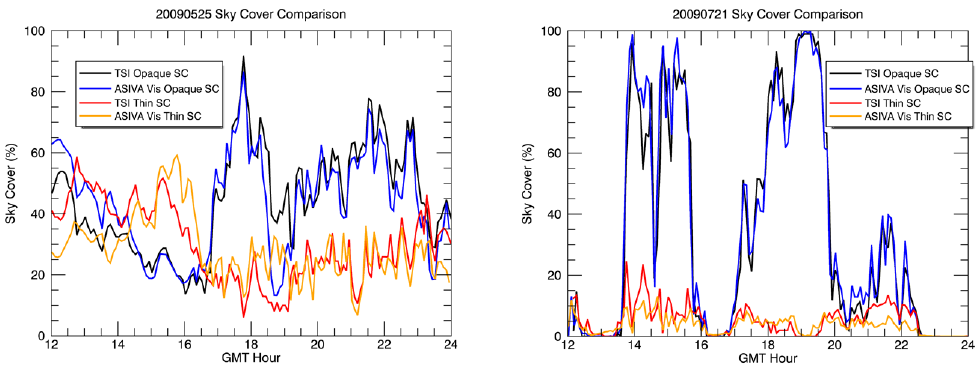
Fig. 9. (a) Sky cover comparisons between TSI and ASIVA visible for opaque and thin cloud types for 25 May 2009 and (b) 21 July 2009. Figure 9. a) Sky cover comparisons between TSI and ASIVA Visible for opaque and thin 2 cloud types for May 25, 2009 and b) July 21, 2009. 3